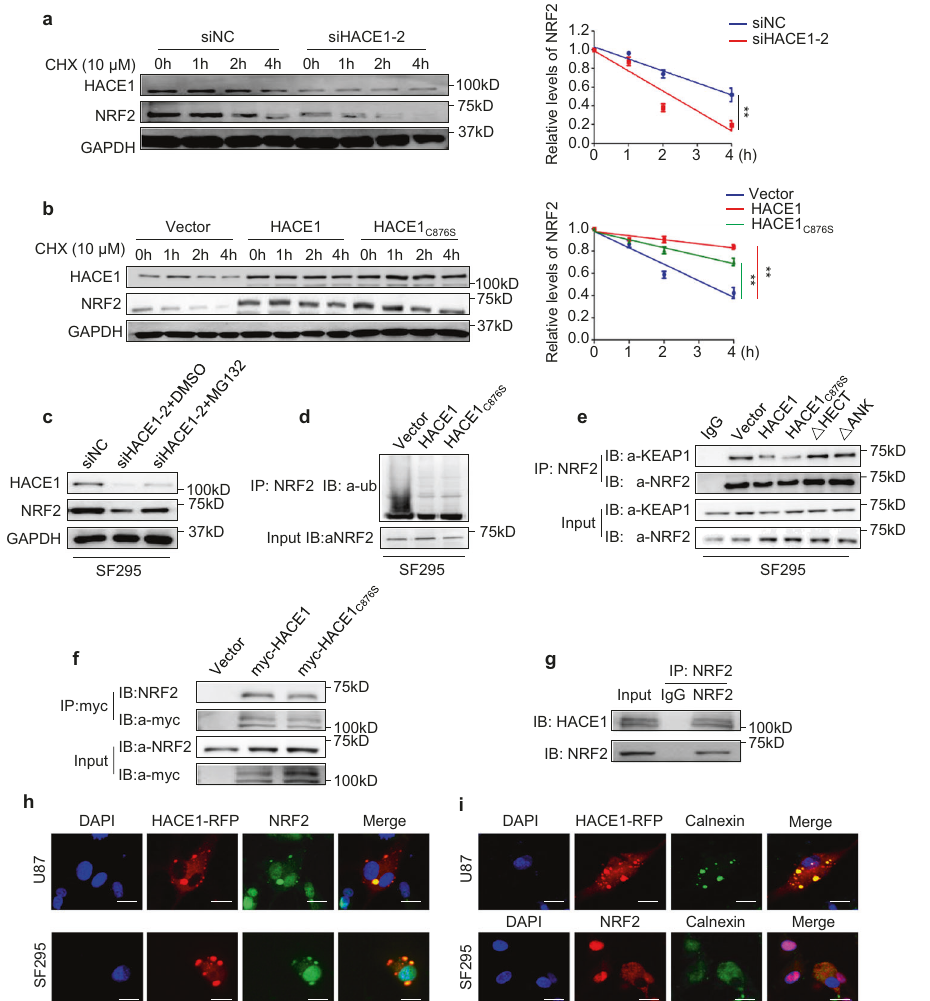
Fig. 4 HACE1 interacts with and attenuates ubiquitin degradation of NRF2. a , b Treatment of the HACE1 knockdown- or HACE1/HACE1 C876S overexpression-SF295 cells and control cells with 10 μ M cycloheximide at the time indicated. Left panels represent western blot analysis of the indicated proteins. The band intensity of NRF2 in cycloheximide-treated cells was normalized to that of GAPDH (loading control), and subsequently normalized to that in DMSO-treated cells (right panels). Data were expressed as mean ± SD. * P < 0.05; ** P < 0.01. c HACE1 knockdown-SF295 cells and control cells were pretreated with 25 µM MG132 or DMSO for 4 h, and western blot analysis was then carried out to assess protein expression of HACE1, NRF2, and GAPDH (loading control). d HACE1/HACE1 C876S overexpression-SF295 cells and control cells were pretreated with 25 µM MG132 for 4 h. Next, cells were lysated and mixed with anti-NRF2 antibody conjugated with agarose. Immunoblotting was then carried out to assess NRF2 ubiquitination using anti-ubiquitin (Ub) antibody. Input samples were taken prior to the above steps. e SF295 cells stably expressing wild-type HACE1 or the indicated mutants and control cells were lysated and immunoprecipitated (IP) with anti-NRF2 antibody, and the precipitated proteins were subjected to western blot analysis using anti-KEAP1 antibody. f , g The interaction between HACE1 and NRF2 was evaluated by reciprocal Co-IP assays in HACE1/HACE1 C876S overexpression-SF295 cells and control cells. h Immuno fl uorescence staining showing the co-localization of HACE1 and NRF2 in the extranuclear region of SF295 and U87 cells. Blue color represents DAPI staining for nuclei; Red color represents HACE1 tagged with red fl uorescence protein (RFP); green color represents NRF2. i Immuno fl uorescence assay showing the co-localization of HACE1 and NRF2 in the endoplasmic reticulum of SF295 and U87 cells. Blue color represents DAPI staining for nuclei; Red color represents HACE1 tagged with RFP or NRF2; Green color represents calnexin. Scale bars, 20 μ